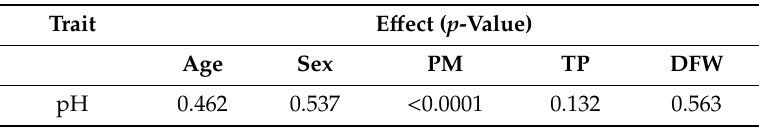
Table 3. The p -Values for the e ff ect of age, sex, point of measurement, time postmortem and the dressed field weight on the pH of meat and o ff